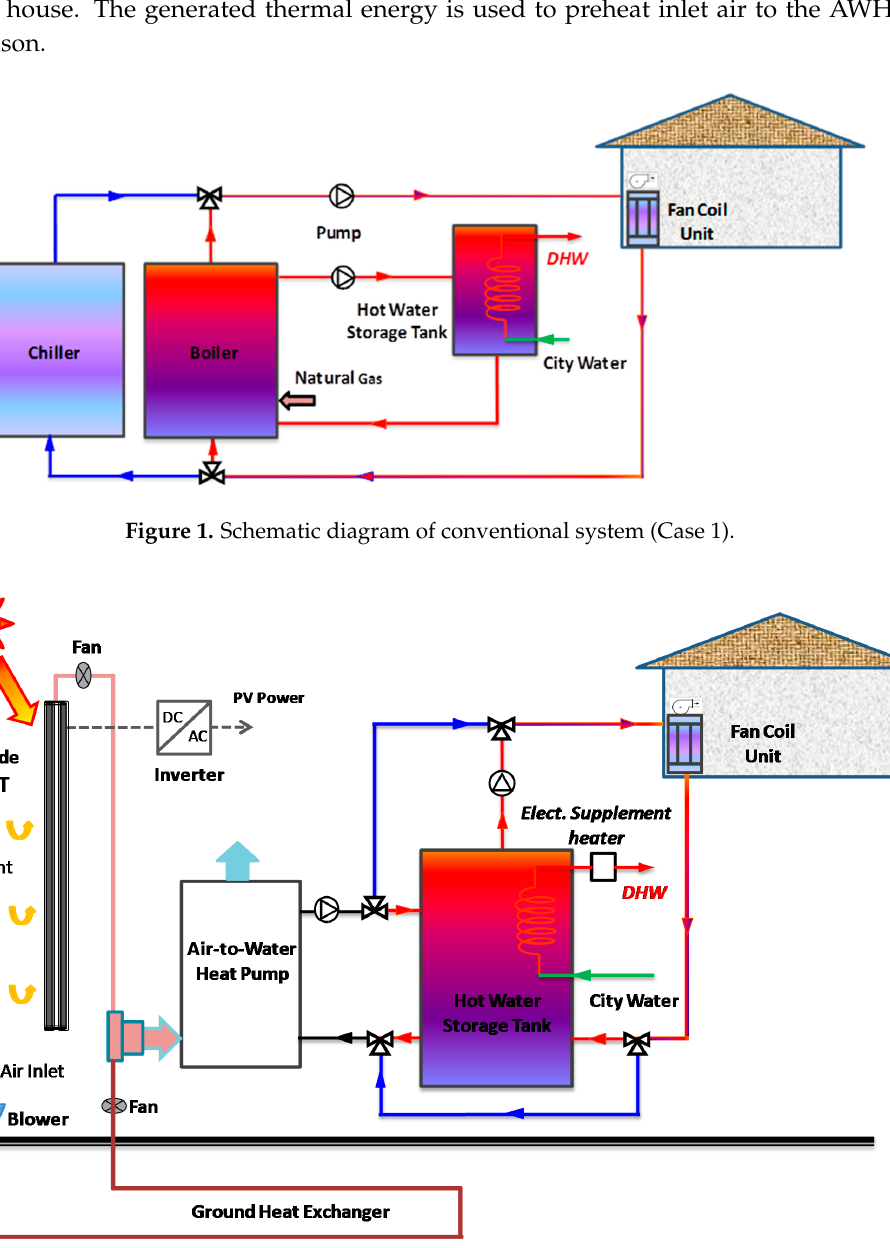
Figure 2. Schematic diagram of trigeneration system with integration of air ‐ to ‐ water heat pump, photovoltaic thermal panels and ground ‐ to ‐ air heat exchanger (Case 2).